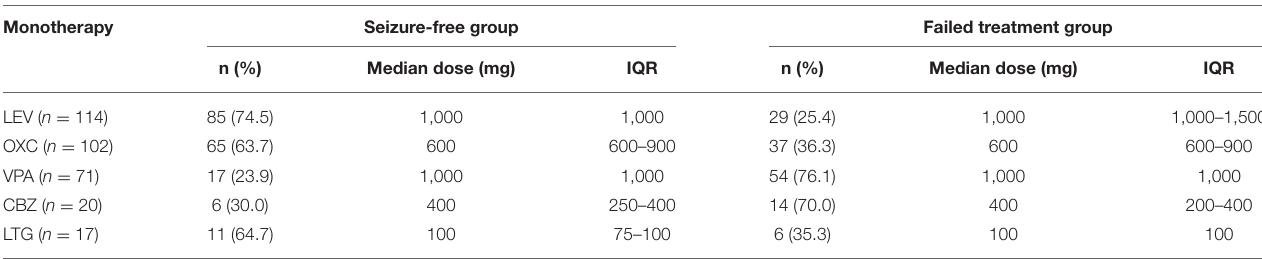
TABLE 2 | Outcomes of antiseizure medication (ASM) monotherapy and their doses within 1 year. Monotherapy Seizure-free group